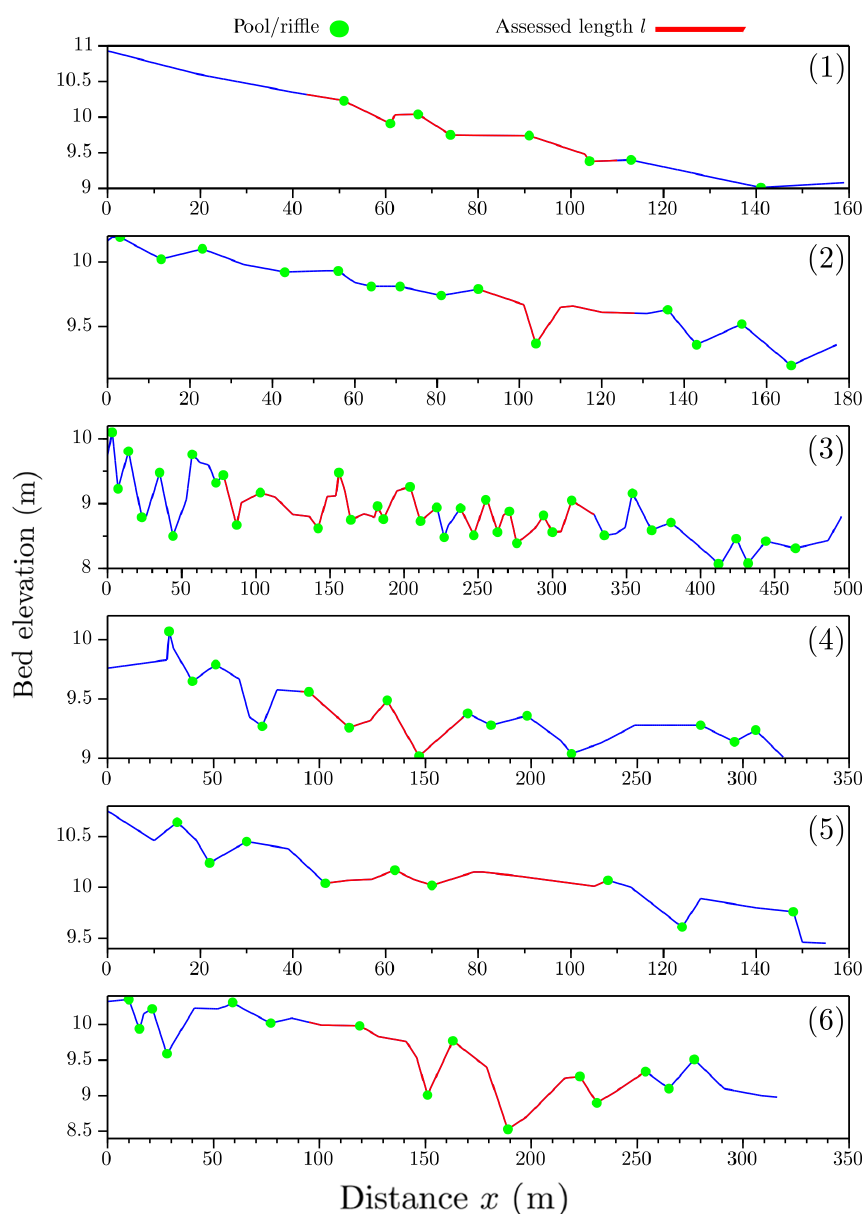
Figure 10. Results of the BDT method using a tolerance equal to the standard deviation on the total length (blue) and the assessed one (red) for all reaches (1 to 6). Round points are pools or riffles: pools are high, and riffles are low